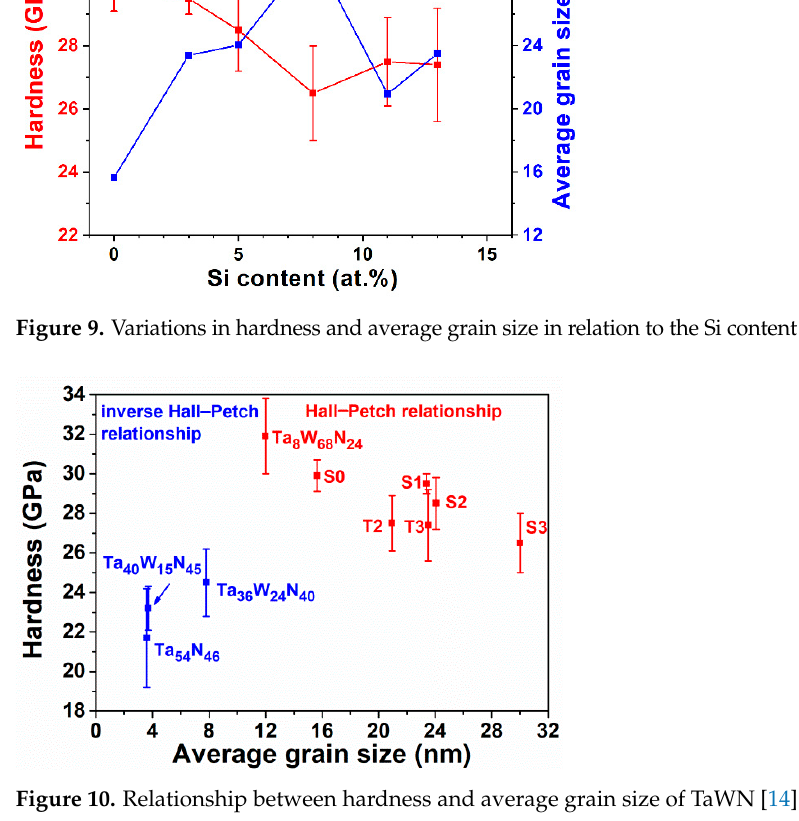
Figure 10. Relationship between hardness and average grain size of TaWN [14] and TaWSiN films.